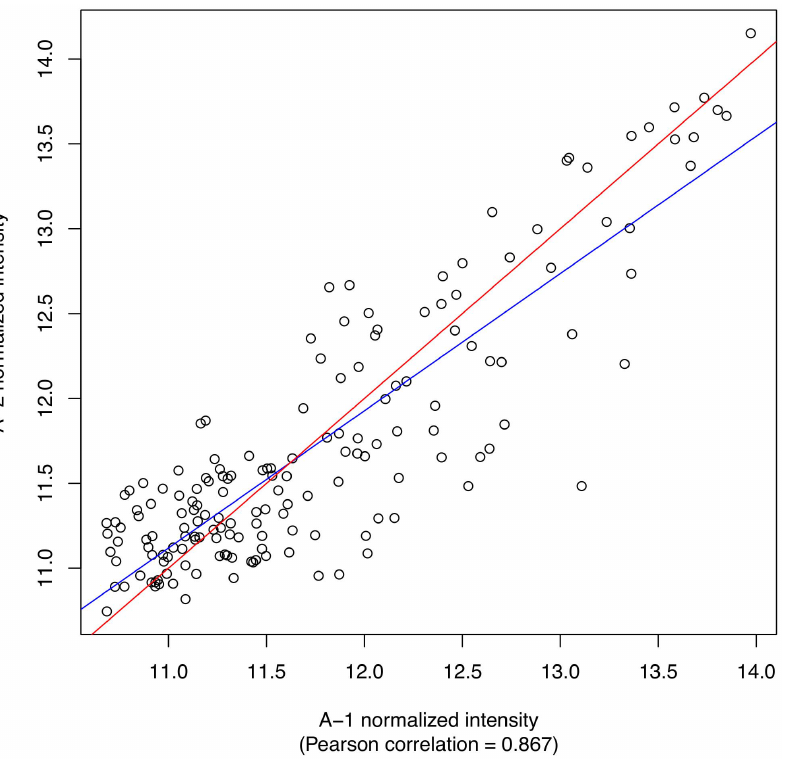
Figure 8. Example of a sample-sample scatterplot generated using PIIKA 2. Each point represents a peptide, and the x and y values of that point represent the normalized intensity values for that peptide for the first sample (A-1) and the second sample (A-2), respectively. The blue line represents the best fit using least squares, whereas the red line simply shows the diagonal ( y ~ x ). The Pearson correlation between the two samples is also indicated.